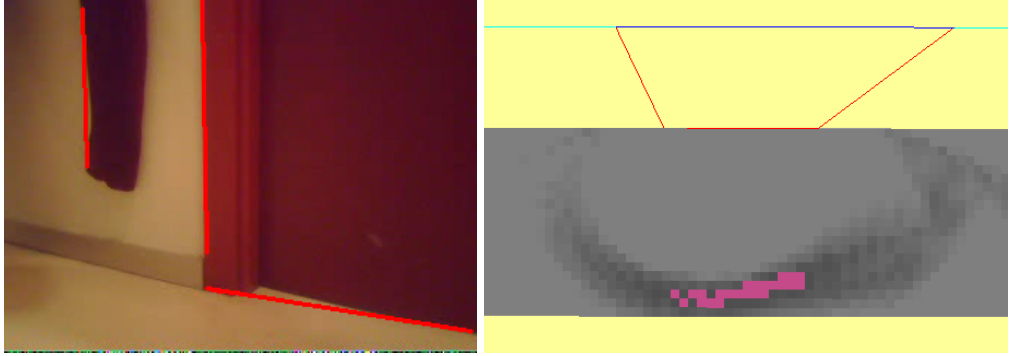
Figure 27. Observed image (left) and calculated probabilities with false positives for any theta